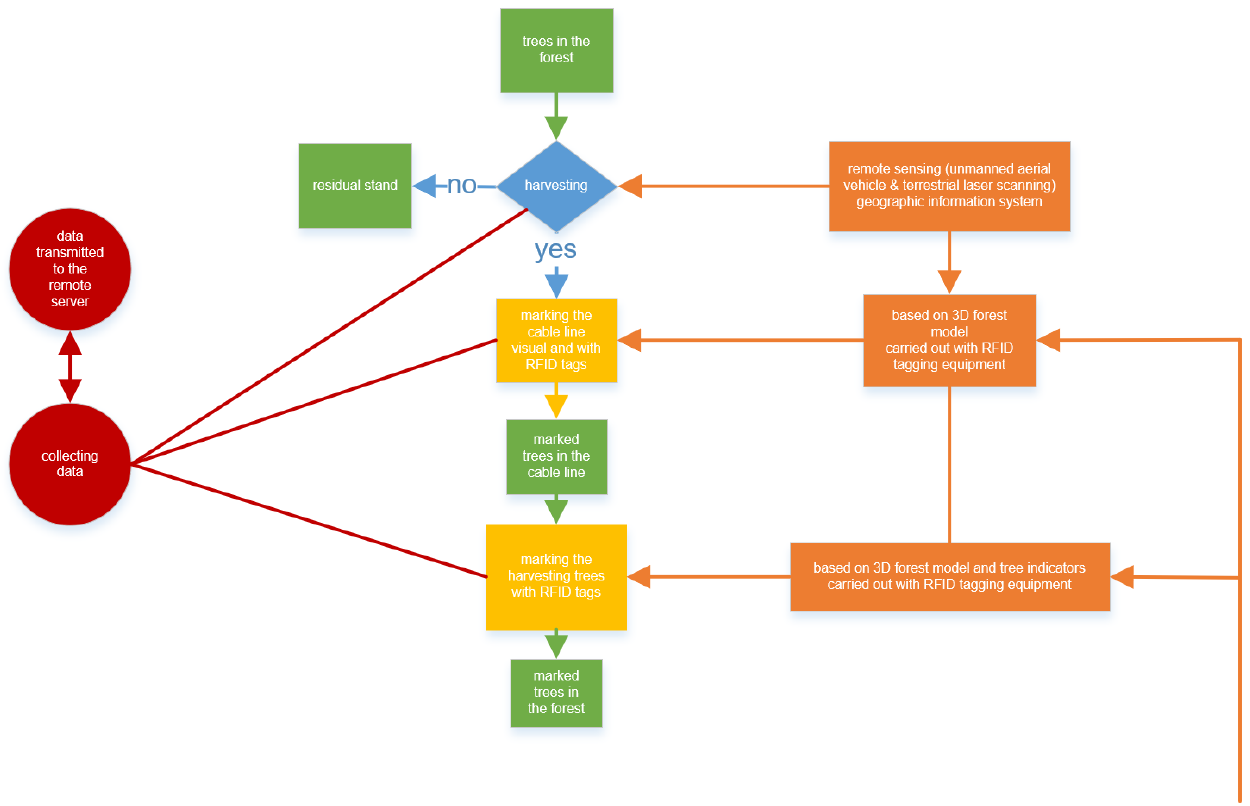
Figure 8. Flow chart “ Trees in the Forest – Marked Trees in the Forest. ” 308